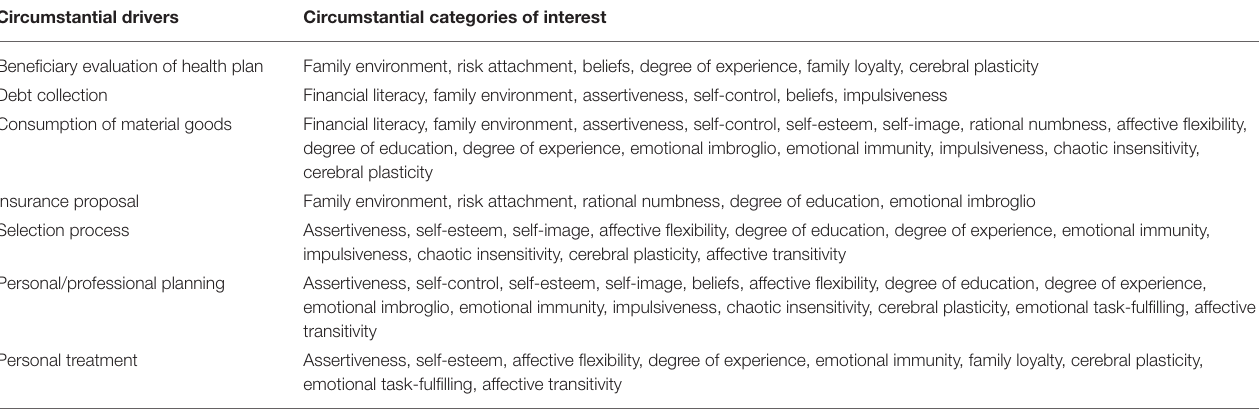
TABLE 4 | Illustration of circumstantial drivers and their respective circumstantial categories of interest. Circumstantial